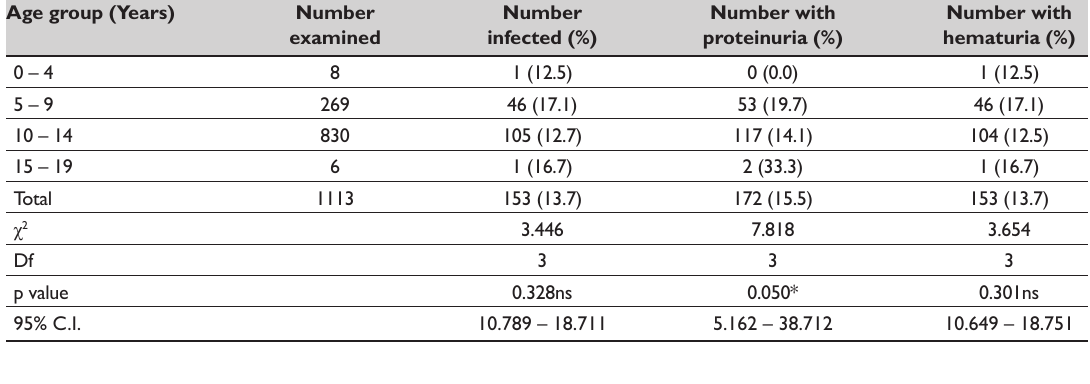
Table 3: prevalence of urogenital schistosomiasis, proteinuria and hematuria in relation to age in the